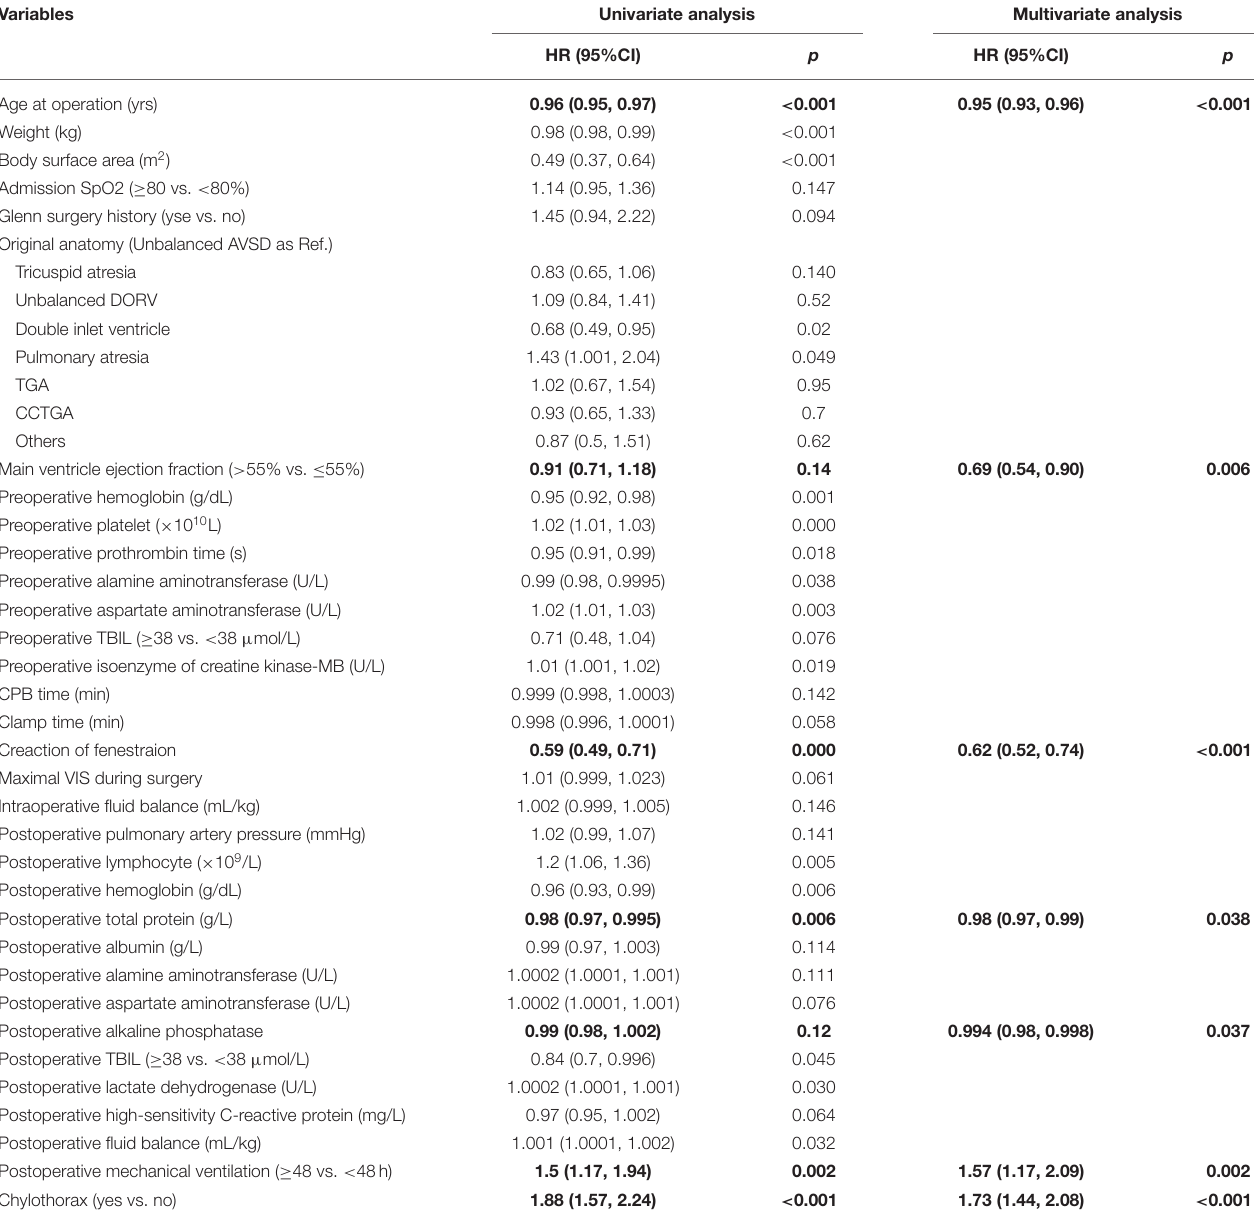
TABLE 5 | Univariate and multivariate Cox analysis hazard ratios for duration of pleural effusions. Variables Univariate analysis Multivariate